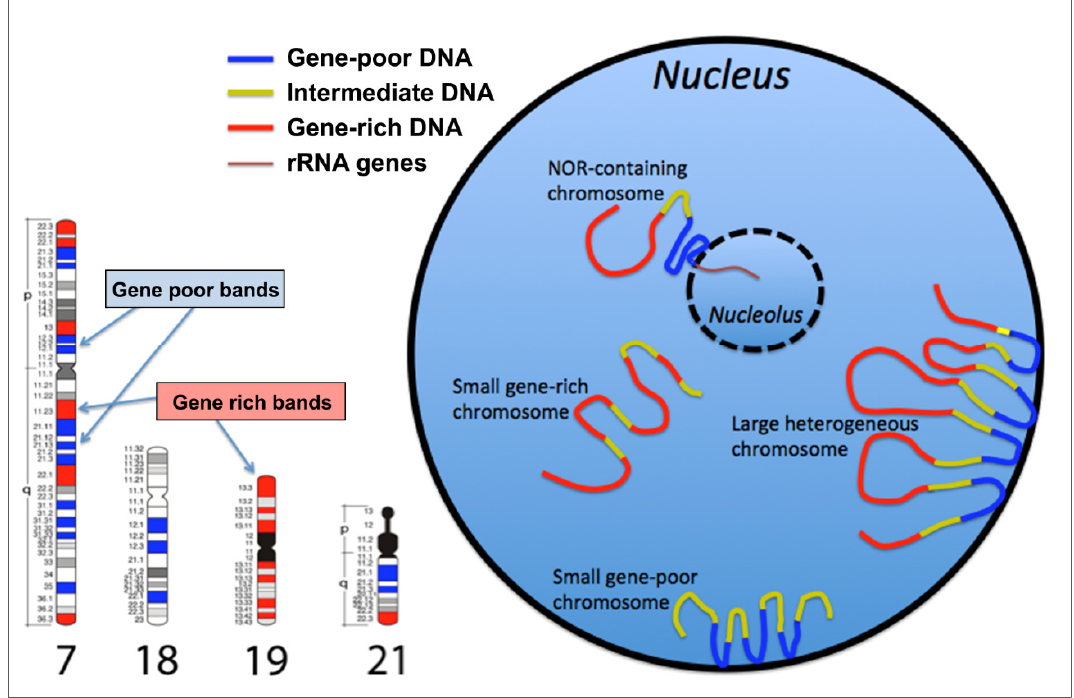
Figure 1. Chromosome organization in the cell nucleus. The left panel displays ideograms of four representative human chromosomes. Red and blue bands indicate the gene/GC-richest and the gene/GC-poorest bands, respectively. The other bands are endowed with intermediate properties. The right panel displays a schematic representation of the chromosomal band sequence distribution through interphase nuclei according to their genomic properties with respect to gene/GC content. Small chromosomes can be located at the nuclear edge or in the interior, with gene-poor chromosomes being located at the nuclear edge and gene-rich in the interior, in proliferating cells. Large chromosomes, generally heterogeneous in their genomic properties (such as the human chromosome 7), assume a “zig-zag” conformation and are positioned with the GC-richest bands exposed towards the interior of nuclei. Nucleolus organizer regions (NOR) containing chromosomes (such as the human chromosome 21) have associations with internal nuclear structure with the GC-poorest bands located close to the